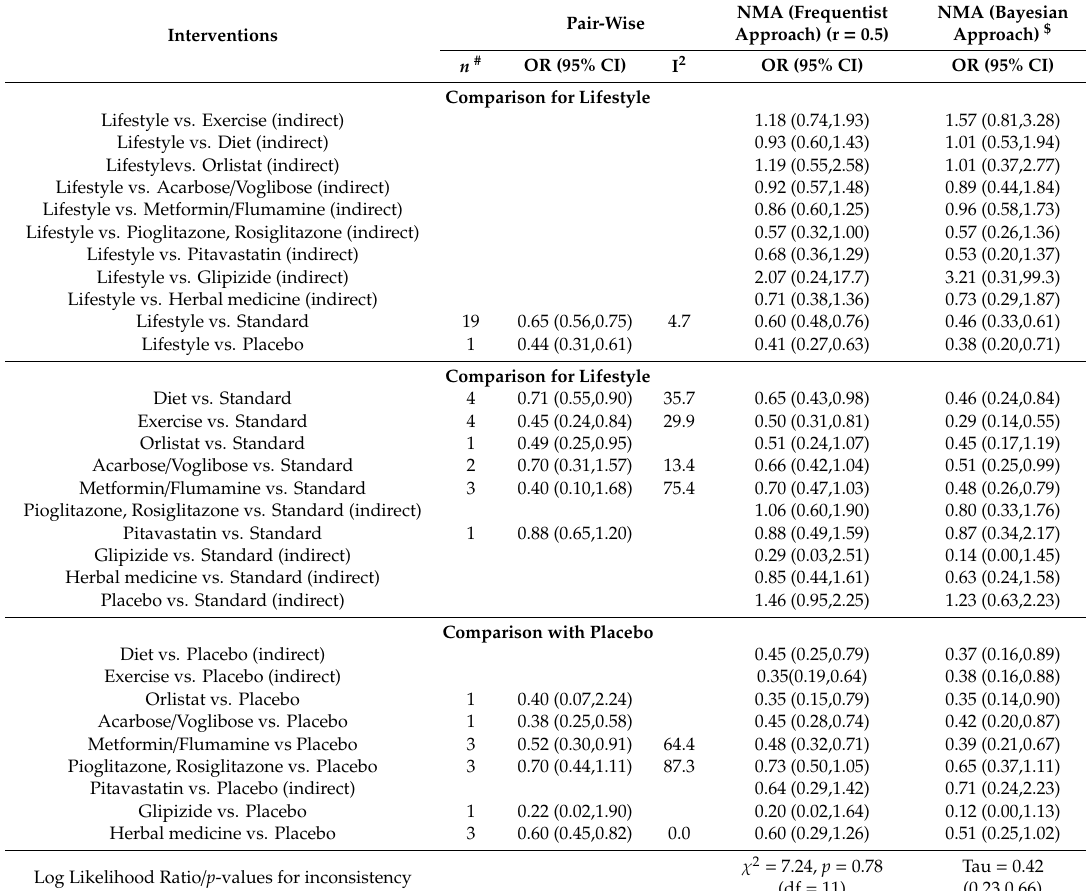
Table 1. Pairwise and NMA: the estimated parameters by frequentist approach and Bayesian approach.